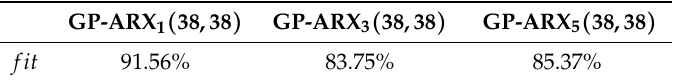
Figure 10. Spring-mass-damper: GPR modelling results for the AR and the eXogenous parameters of the associated ARX models. Table 3. Spring-mass-damper: GPR modelling results for the noise variance of the associated ARX